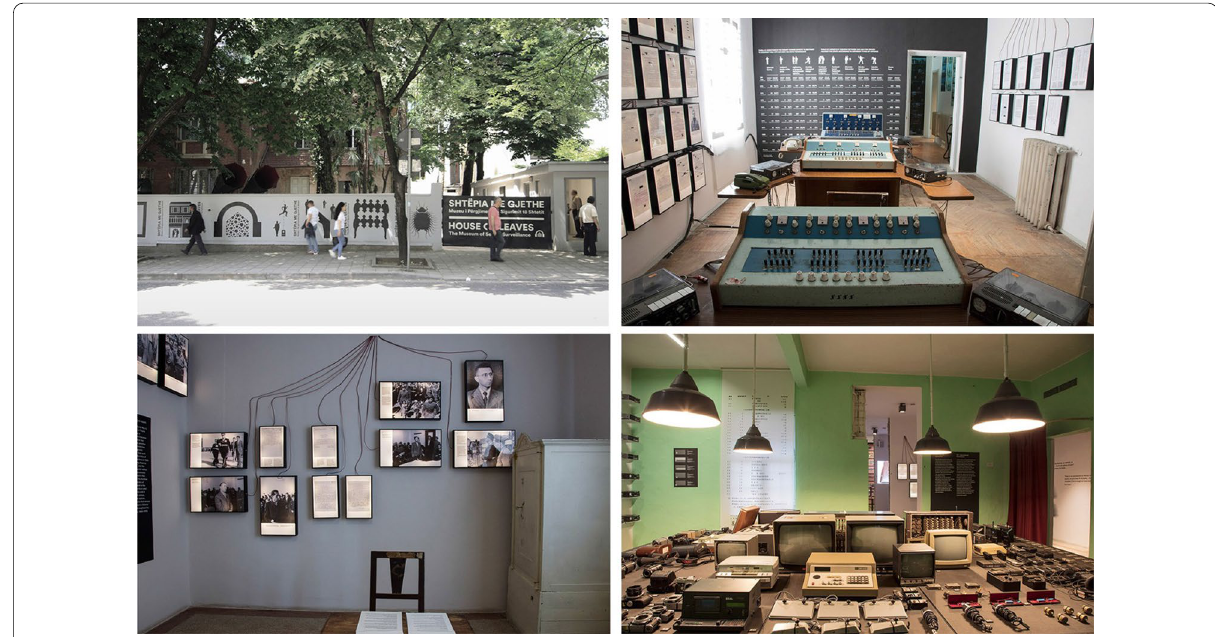
Fig. 13 Picture from the interior of the museum “The House of Leaves”, Studio Terragni